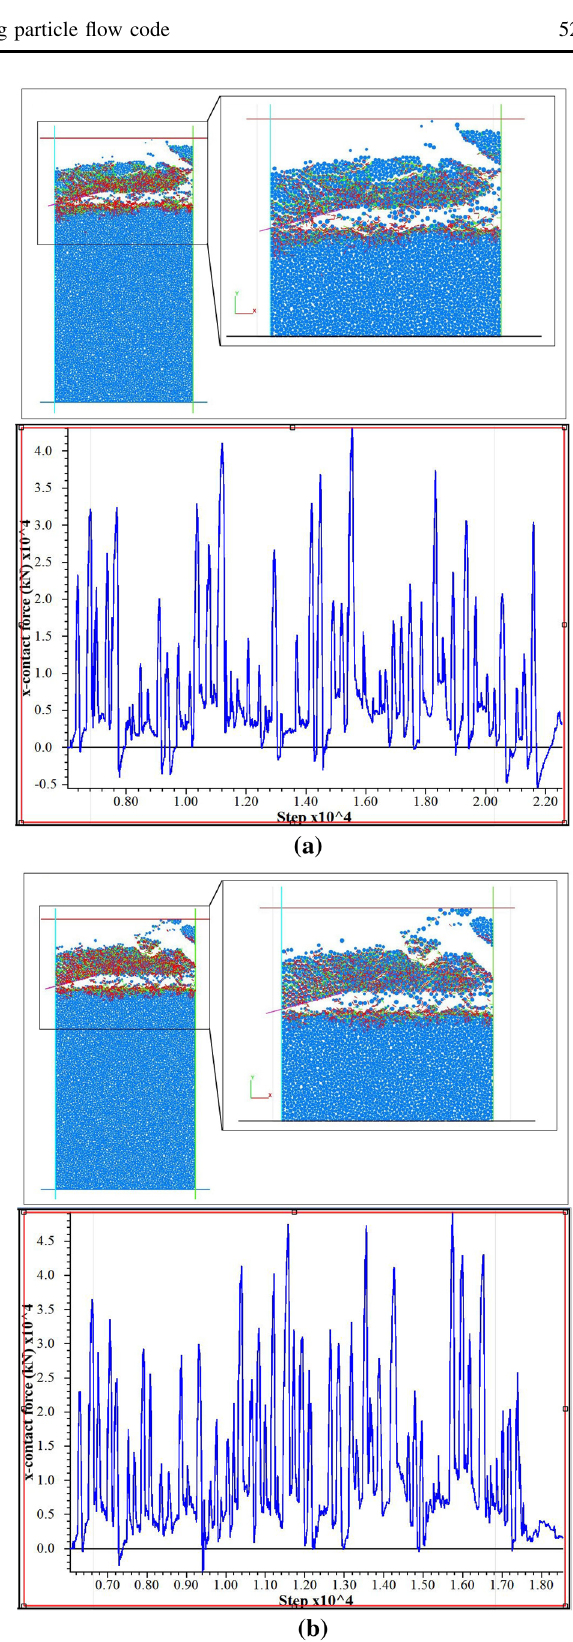
Fig. 10 Results of plow model with zero-degree angle: a Model 7, b Model